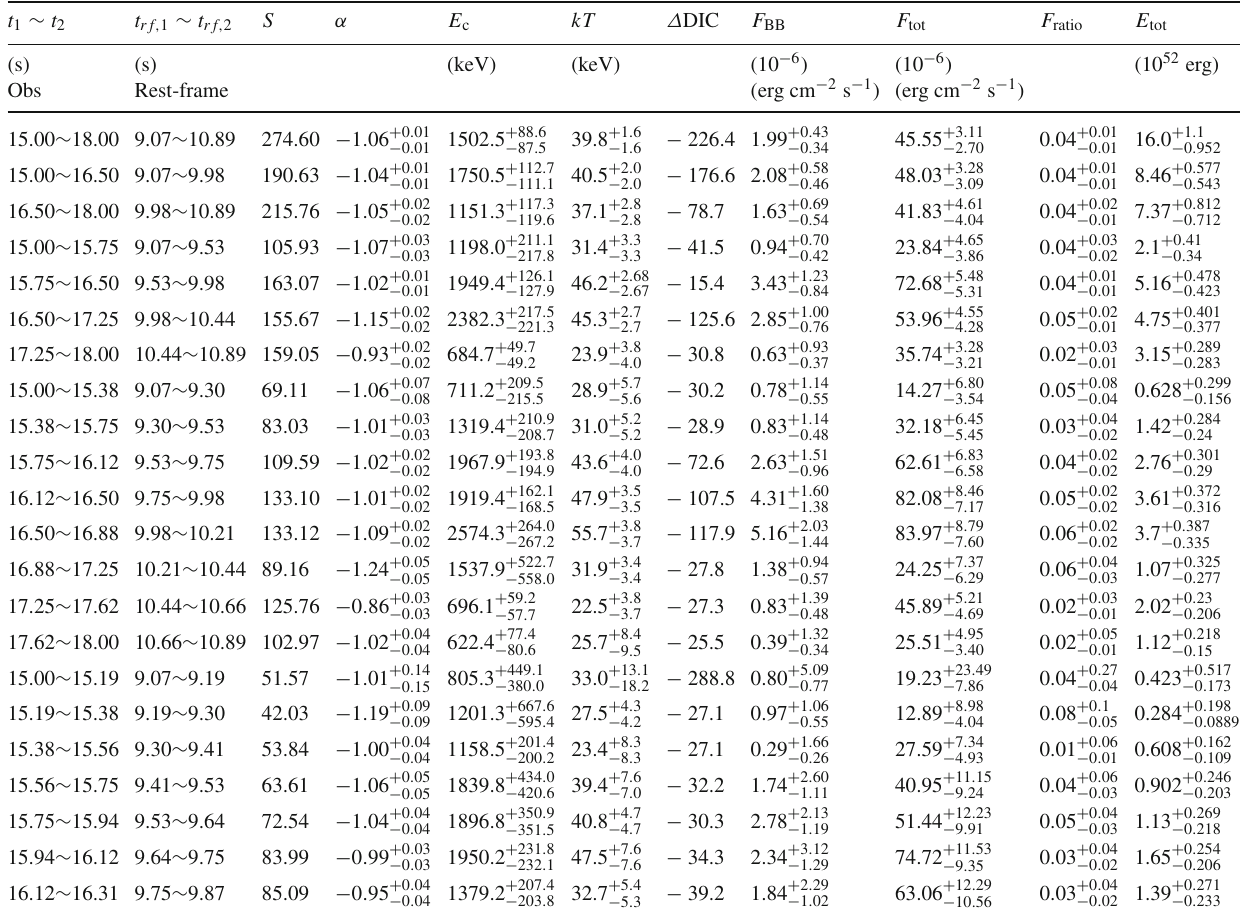
Table 2 The parameters of the time-resolved spectral best fits of GRB 180720B (CPL + BB model) from the t rf = 9 . 07 s to t rf = 10 . 89